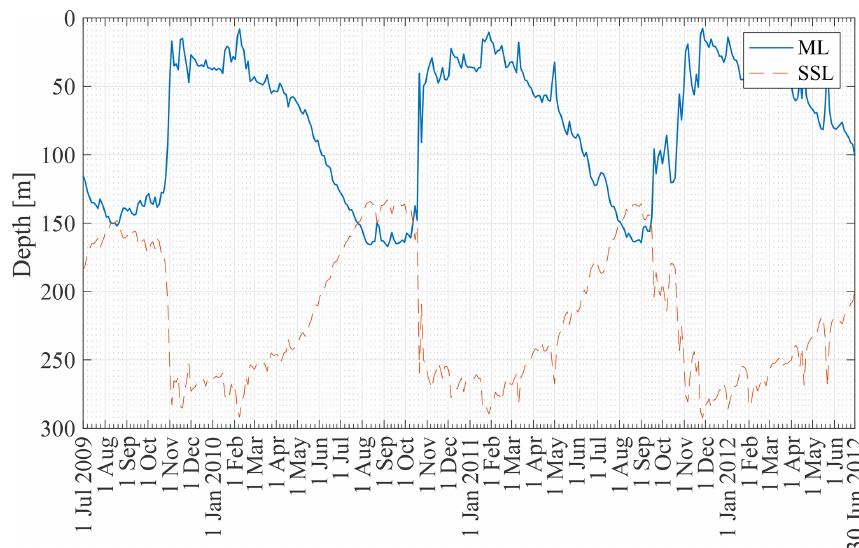
Figure 6. Mixed-layer and subsurface layer thicknesses at station 18 from 1 July 2009 to 30 June